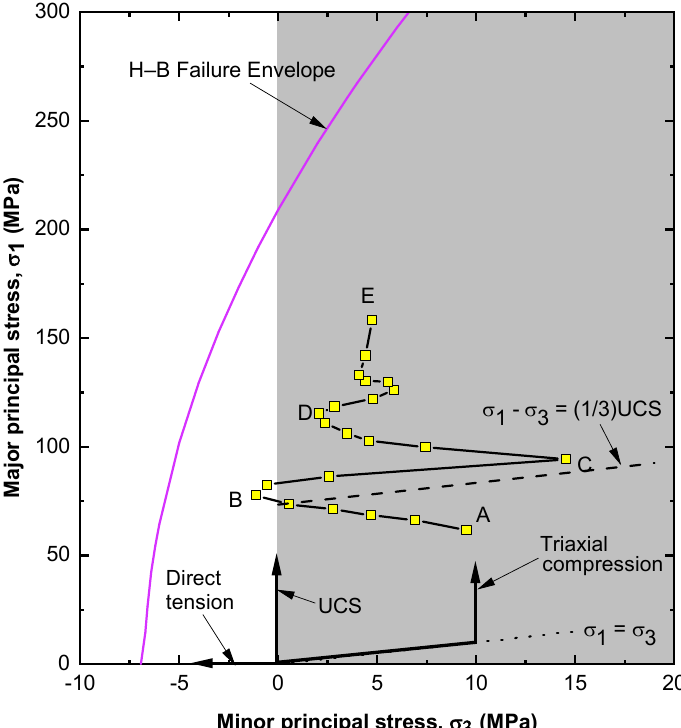
Figure 1. Stress path obtained for a point 50 mm above the crown of a mine-by tunnel using 3D numerical modelling [9]. The Hoek–Brown (H–B) failure envelope and the stress path for direct tension, UCS, and triaxial tests are also shown. The thick dashed line represents the stress level above which crack initiates in rock.